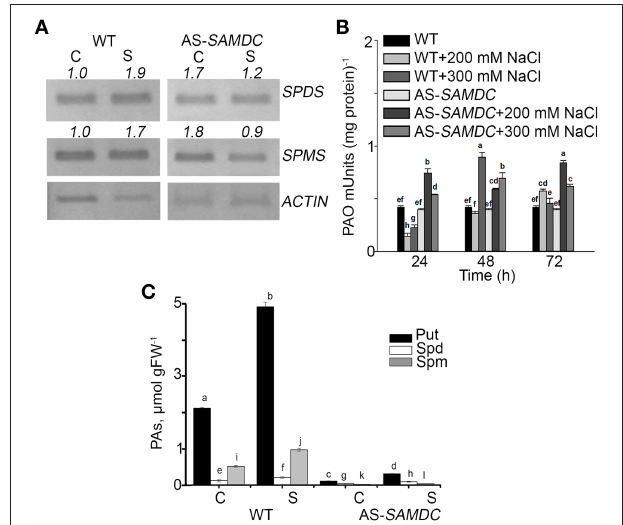
FIGURE 2 | Polyamine homeostasis in WT and AS- SAMDC plants under control and NaCl treatment. (A) Semi-quantitative RT-PCR analysis of SPMS and SPDS in control (C) or 100 mM NaCl (S) conditions. Numbers indicate pixel intensity of corresponding bands normalized according to ACTIN . (B) PAO activity in control and 24, 48, and 72h post-treatment with 200 or 300mM NaCl. Data are means ± SE of three biological replicates with three technical replicates each. (C) PA levels in WT and AS- SAMDC plants in control (C) or 200mM NaCl (S). Data are means ± SE of three biological replicates and different letters indicate significant difference (Student’s t -test, P <